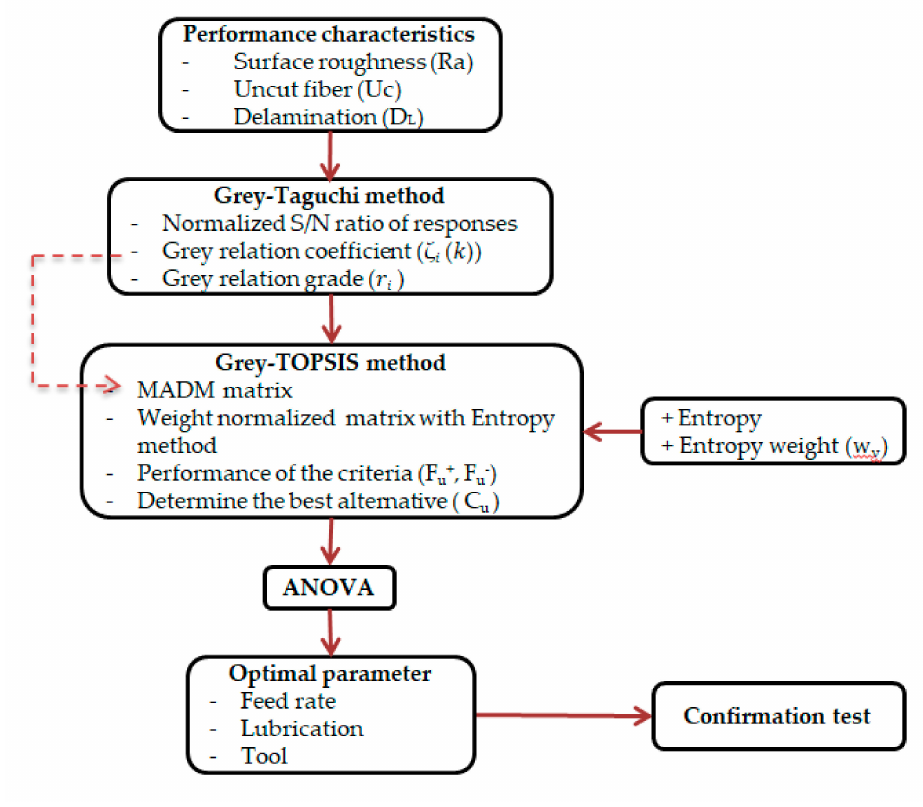
Figure 6. Flow diagram of the optimization and